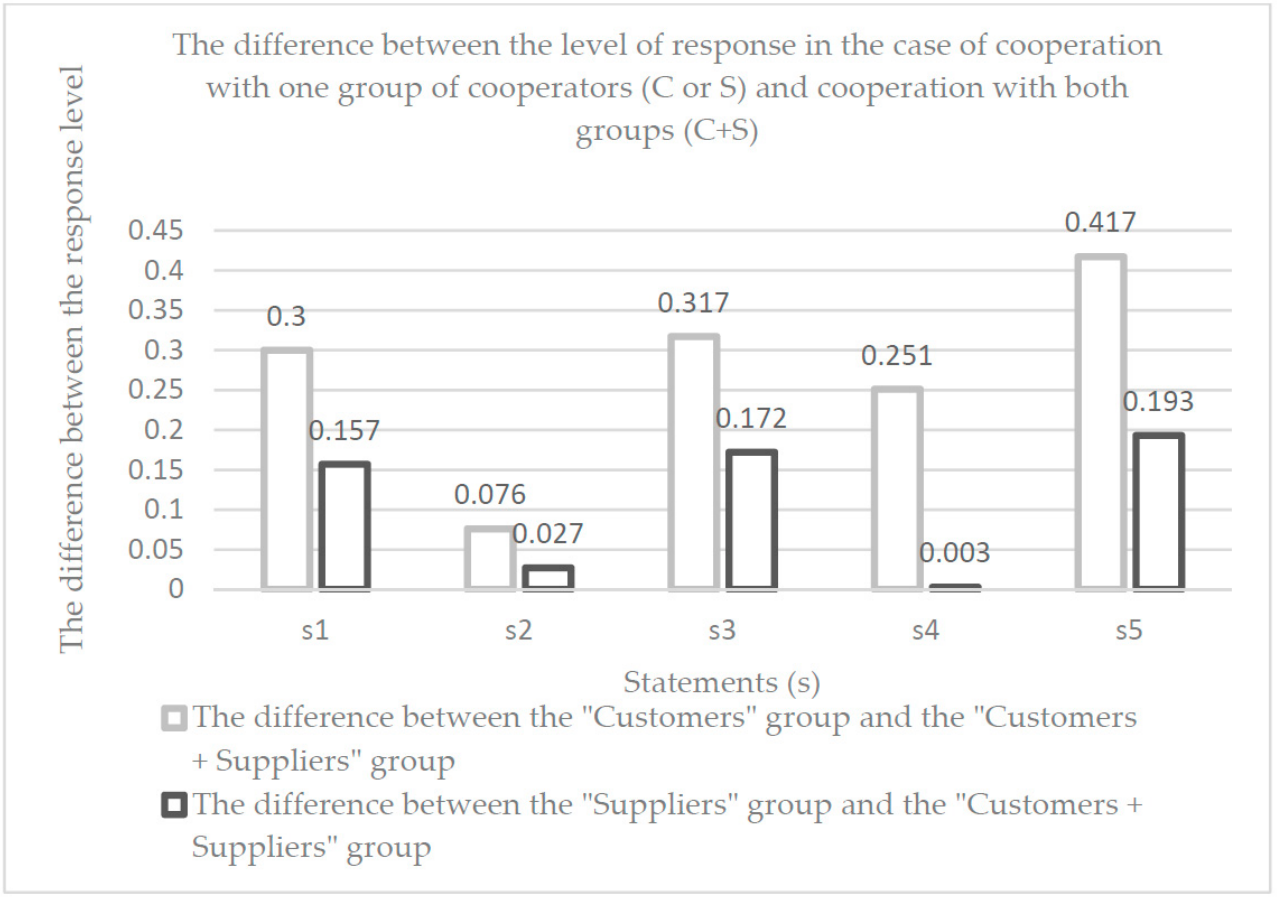
Figure 8. The level of differences in the statements between the Groups: Customers vs. Customers and Suppliers and Suppliers vs. Customers and Suppliers.